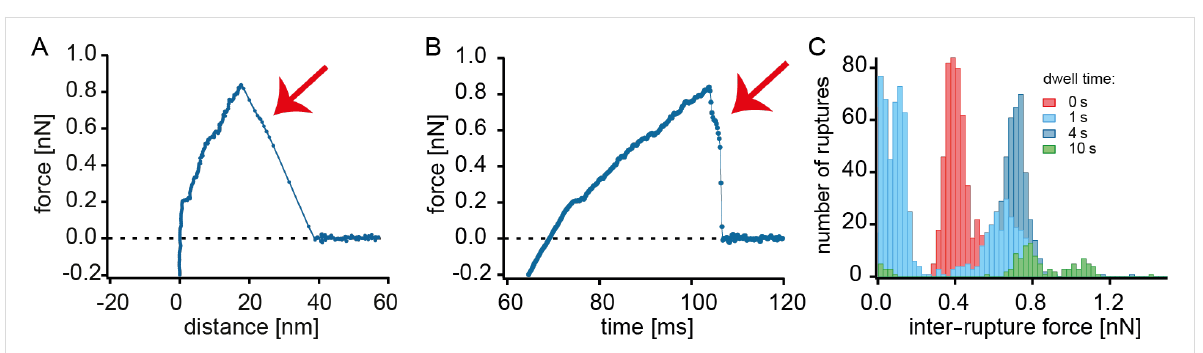
Figure 4: A) Force–distance curves where the rupture is not smooth but rather interrupted by a cluster of measurement points. This inter-rupture force is indicated by a red arrow. B) Same curve as in A) depicted as force vs time. C) Histograms of inter-rupture forces for the different dwell